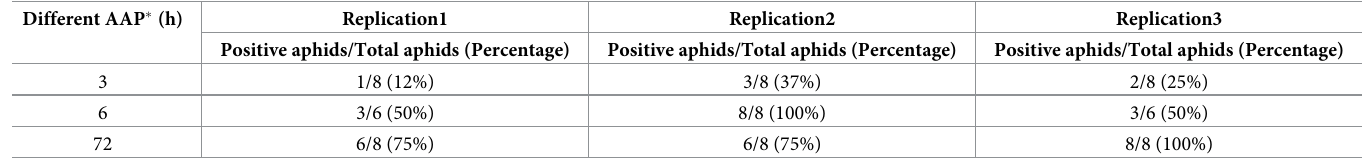
Table 1. CGMMV acquisition by M . persicae